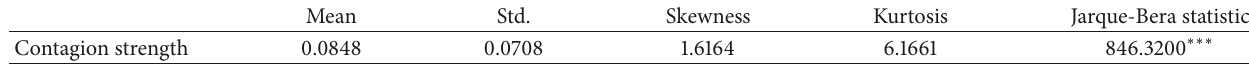
Table 3: Descriptive statistics of the contagion strength for the entire crisis period.